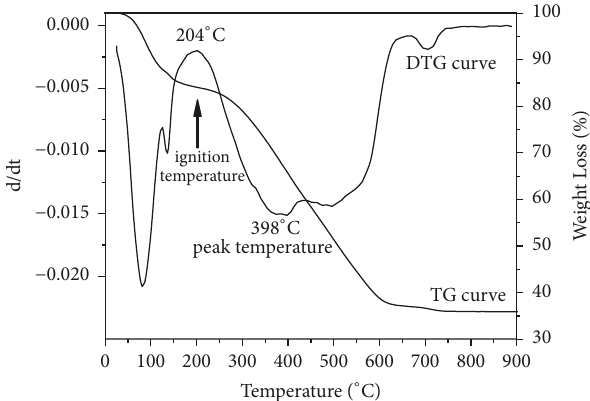
Figure 2: TG and DTG curves with ignition and peak temperatures of the coal